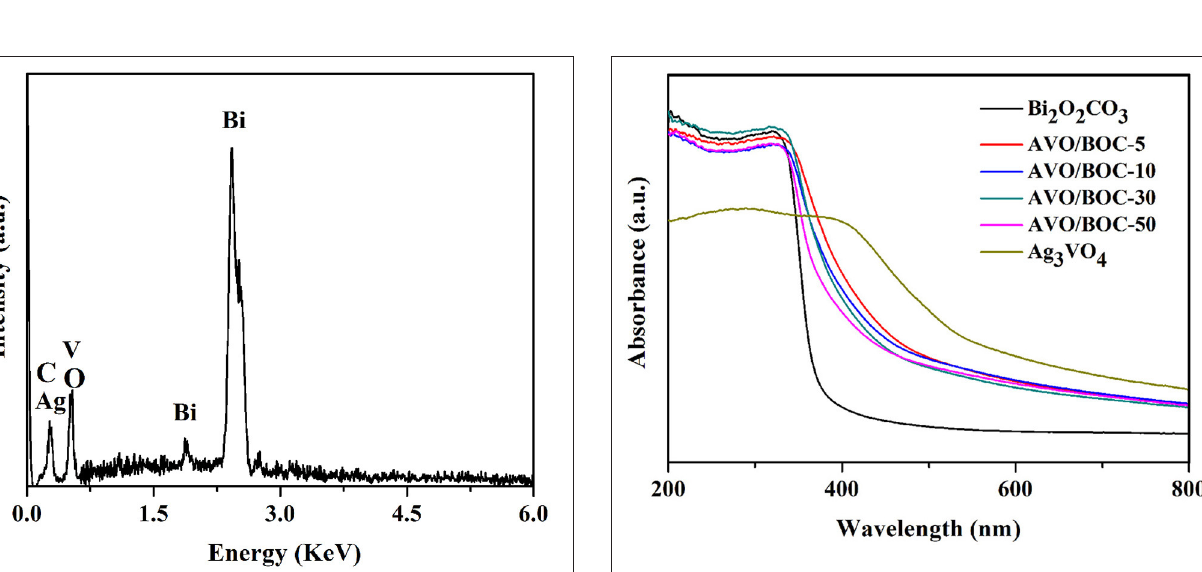
FIGURE 4 | The UV–Vis DRS of bare Bi 2 O 2 CO 3 , Ag 3 VO 4 and Ag 3 VO 4 /Bi 2 O 2 CO 3